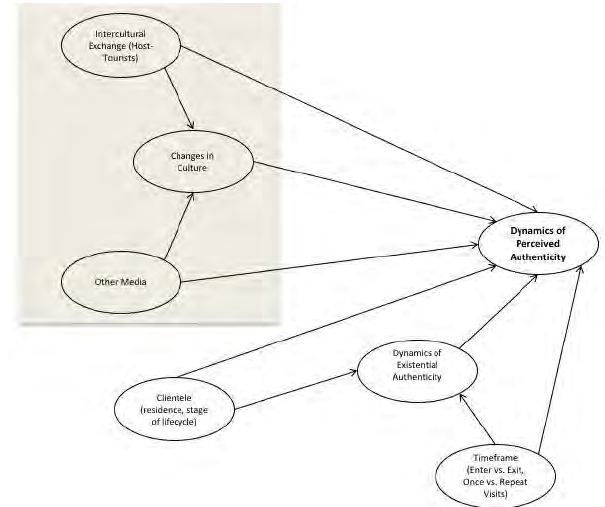
Figure 10. A hypothetical model for the dynamics of authenticity